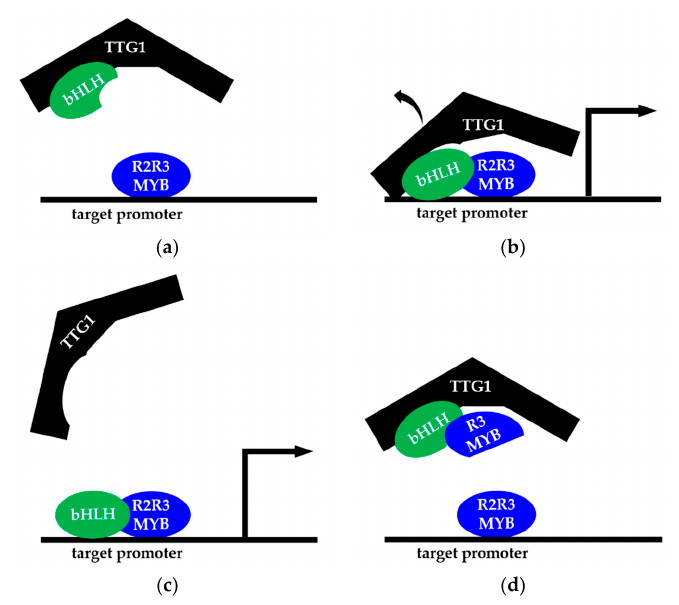
Figure 5. One speculative scenario illustrating the diverse missing links between MBW(AtTTG1) regulatory mechanisms. See the text for the details.